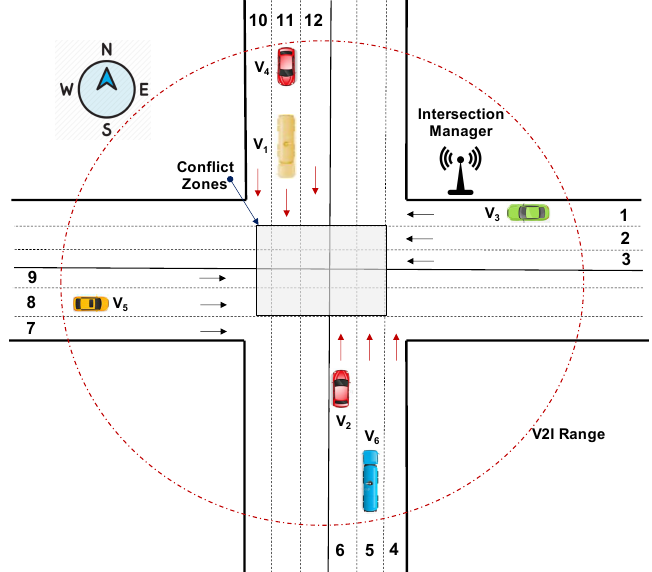
Figure 5. Standard 6-lane 4-leg intersection management. Source: Adapted from Reference [37].